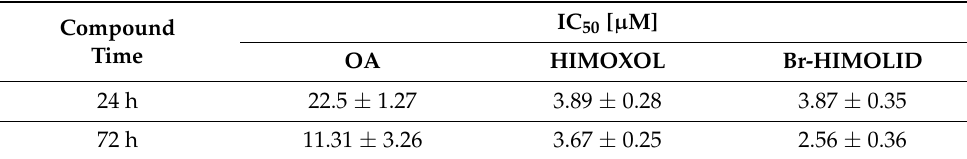
Table 1. Comparison of OA and its two semisynthetic derivatives cytotoxicity in SK-BR-3 cells. The IC 50 values were calculated based on the dose-response curves assessed by the MTT assay for 24 and 72 h.